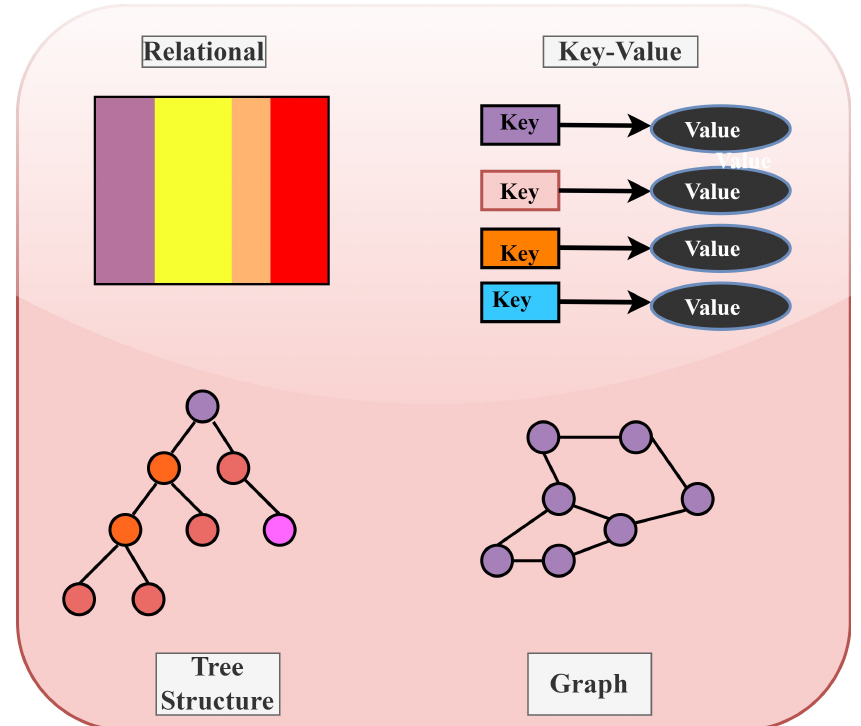
Figure 7. No SQL data structures: generic